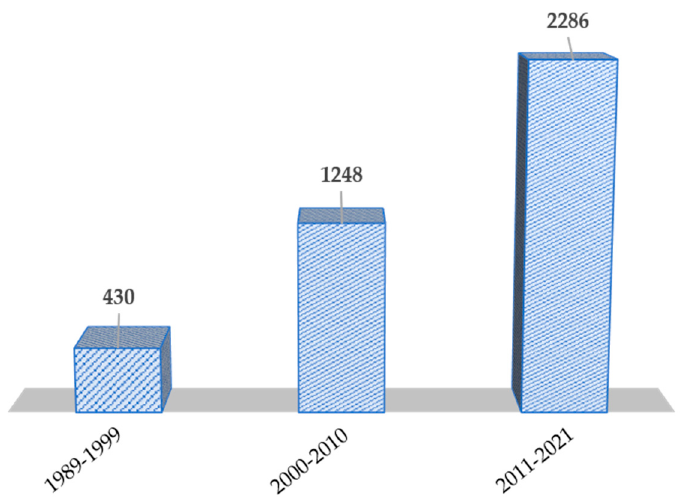
Figure 1. Number of publications in the field of platinum recovery in last three decades. Data was obtained through Scopus search motor (June 2021).